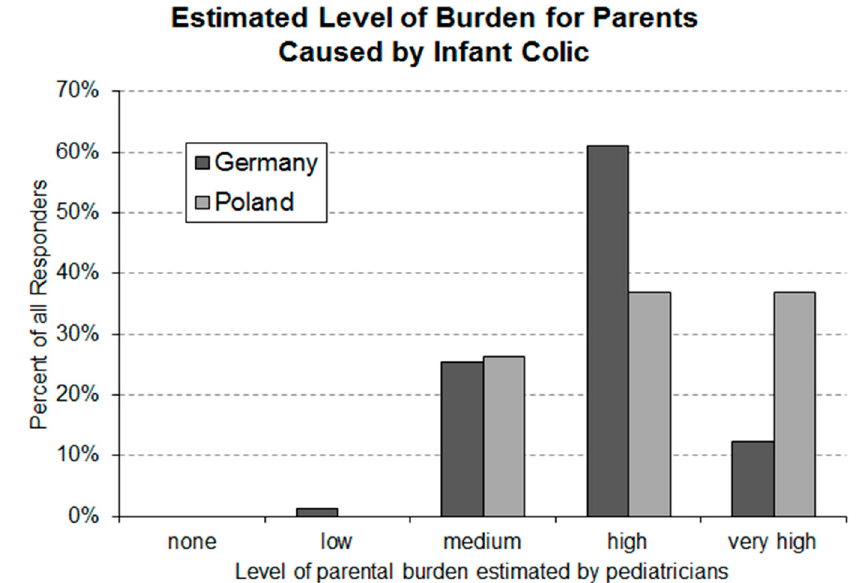
Figure 2. Level of parental burden caused by infantile colic estimated by German ( n = 159) and Polish ( n = 133) pediatricians. Statistical analysis using an asymptotic Linear-by-Linear Association Test revealed a highly significant ( p -value = 0.00255) between-country difference.